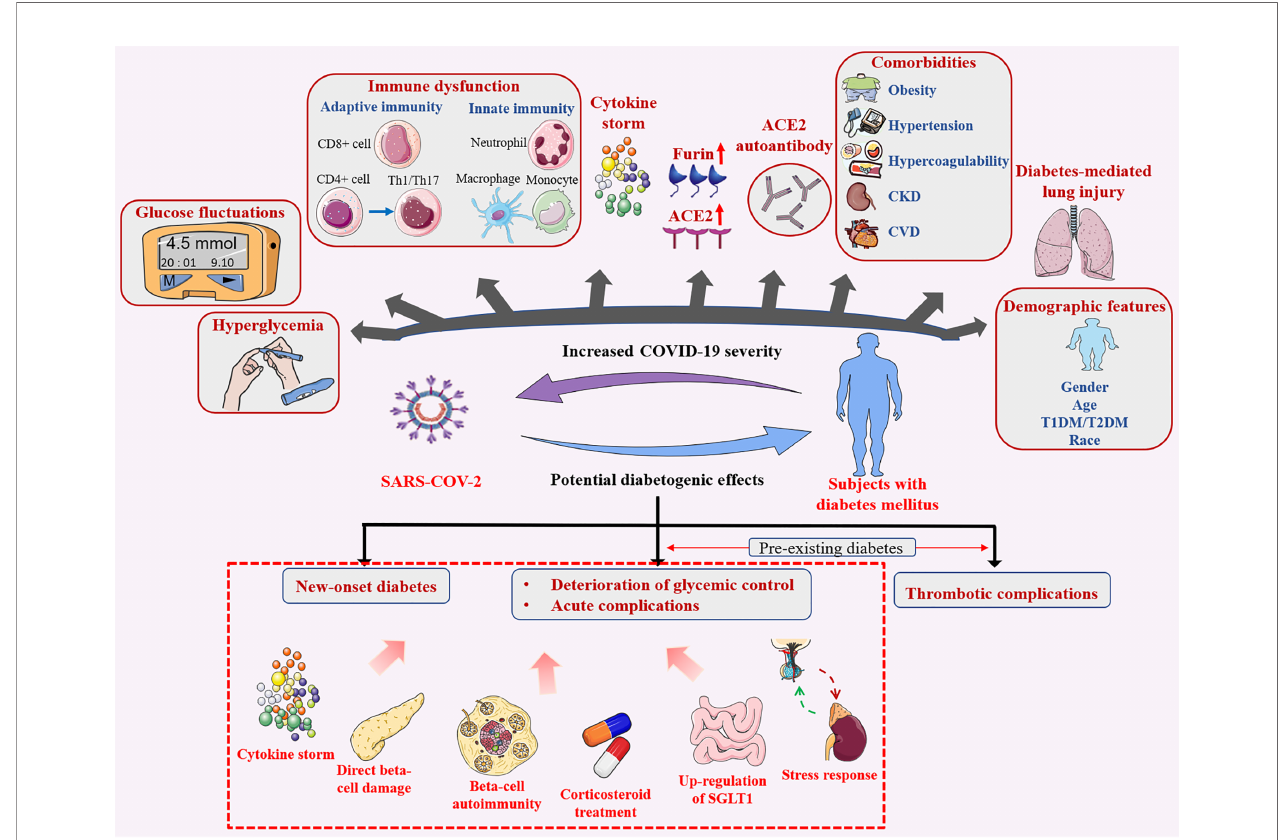
FIGURE 4 | Bidirectional effects between diabetes mellitus and SARS-CoV-2 infection. Diabetes mellitus contributes to poor infection outcomes, SARS-CoV-2 infection has potential diabetogenic